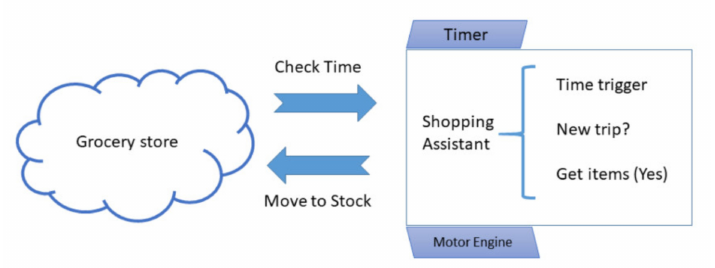
Figure 3. Simple grocery shopping assistant as an agent-based CPS